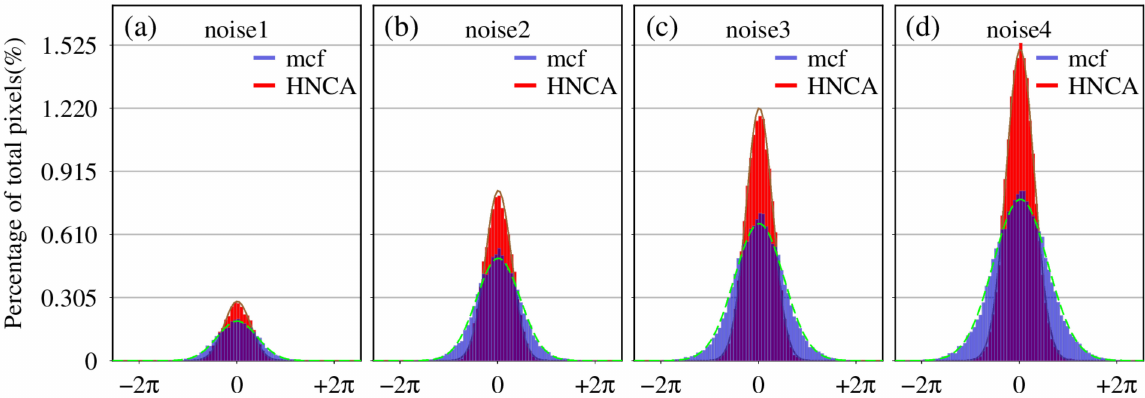
Figure 17. Distribution statistics of unwrapping error of low-quality second-level points under different noise